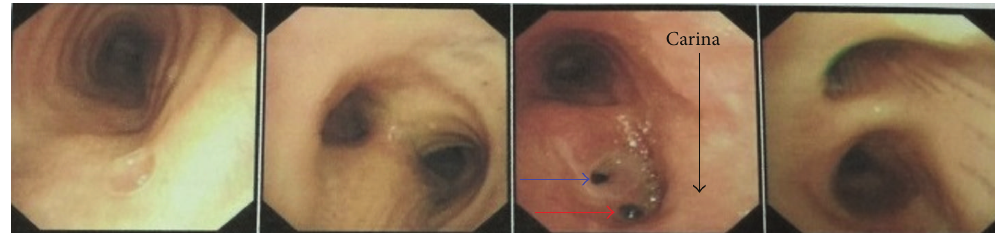
Figure 1: Bronchoscopy showing the presence of a bronchoesophageal fistula (blue arrow) and an ulcer (red arrow) in the left main bronchus.